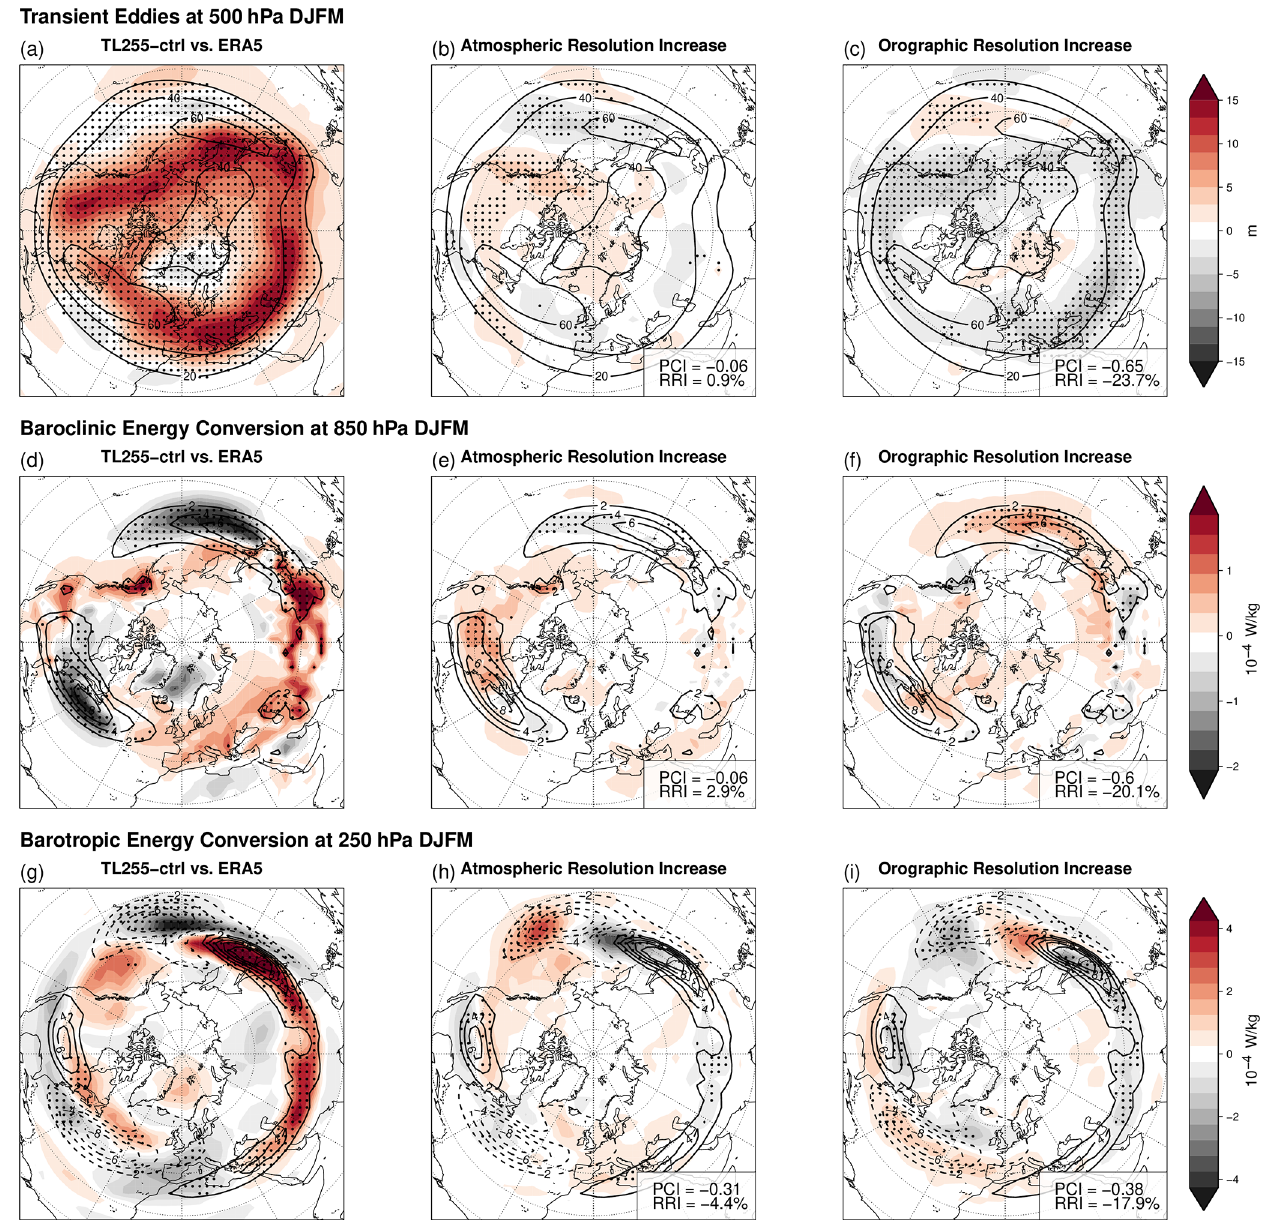
Figure 5. DJFM mean transient eddies’ standard deviation (a–c) , low tropospheric baroclinic energy conversion (d–f) and upper-level barotropic energy conversion (g–i) for (a, d, g) EC-Earth3 TL255-ctrl bias with respect to ERA5, (b, e, f) changes induced by the atmospheric resolution increase and (c, f, i) changes induced by the orographic resolution increase. Shading shows differences and contours the TL255- ctrl field. Stippling indicates significance with a Welch t test at the 5% level. In (b) , (c) , (e) , (f) , (h) and (i) the PCI and RRI (see text for details) are reported at the bottom left of each panel: large negative values imply reduced